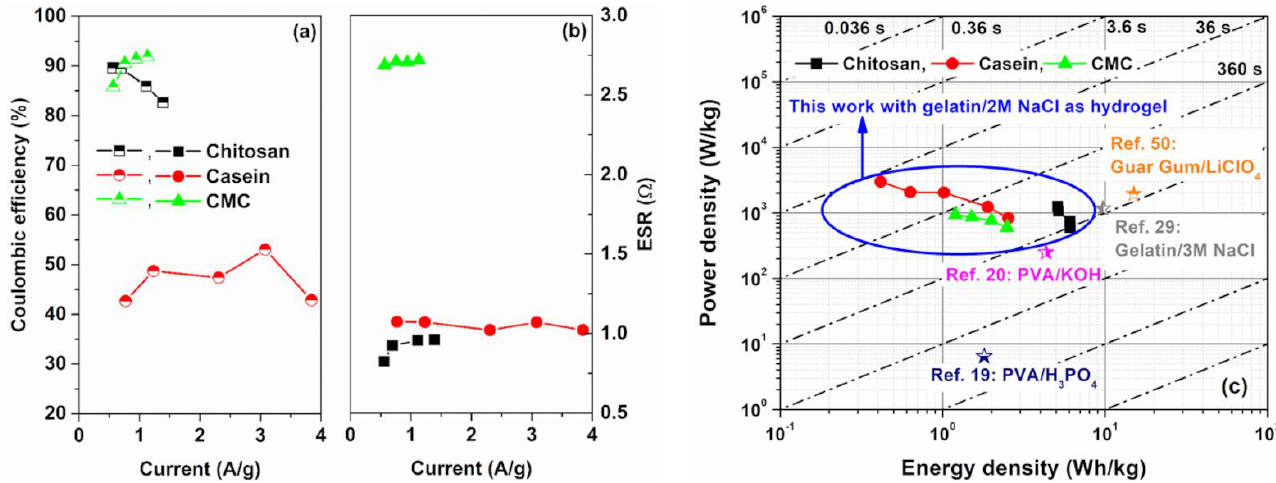
Figure 5. Current dependence of the ( a ) coulombic efficiency and ( b ) equivalent series resistance values as a function of the binders investigated, respectively; ( c ) Ragone plot of gravimetric power density versus gravimetric energy density for the investigated electrodes in comparison with other reported symmetric environmentally—friendly hydrogel carbon-based SCs with their associated time constant regimes [19,20,29,50].